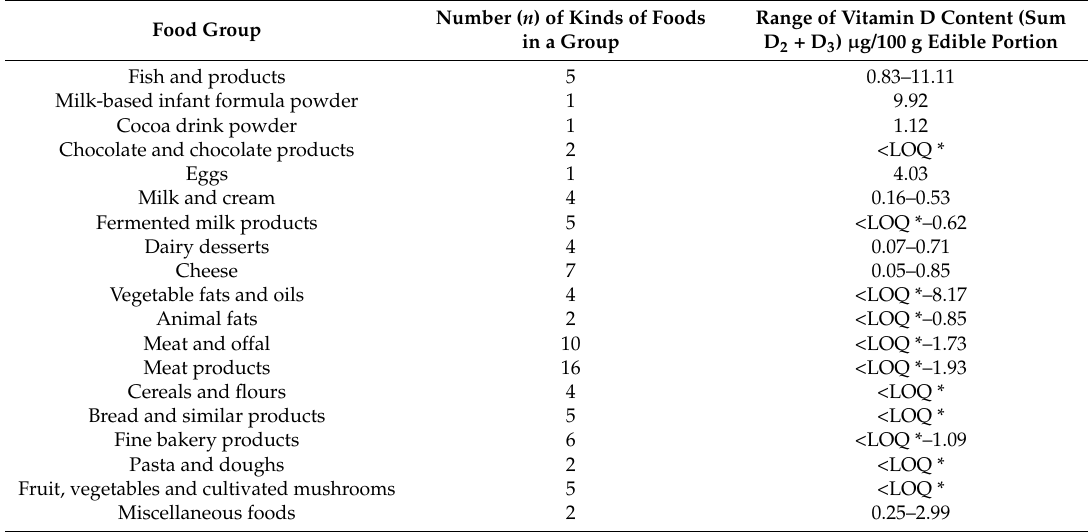
Table 4. Overview of vitamin D content in analyzed food